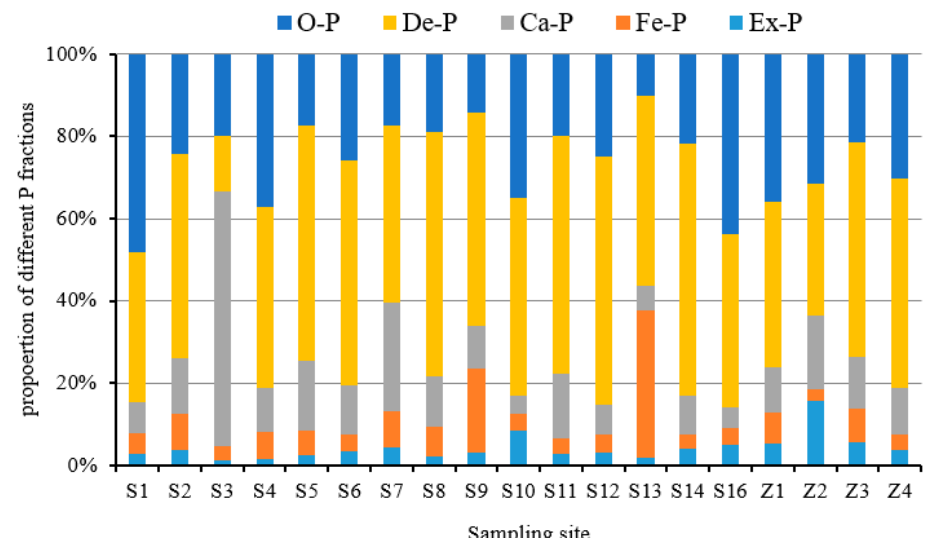
Figure 4. Composition of different P fractions in the surface sediment of Daya Bay, China.